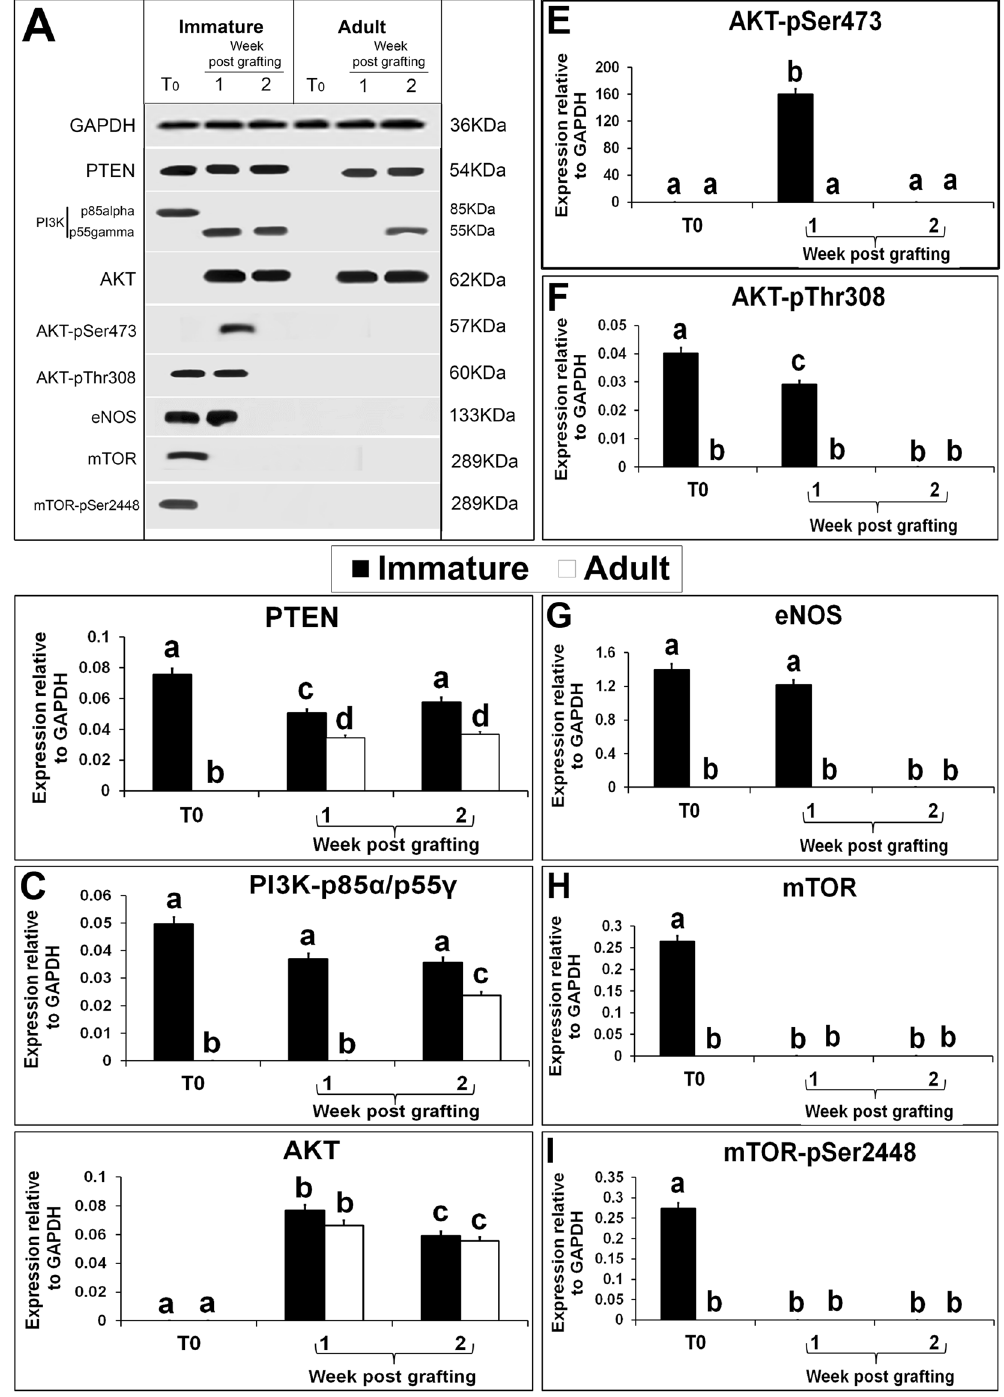
Figure 6. Western blot analysis of xenografted immature and adult testes at 1-and 2-wk-post grafting for expression of PI3K/AKT/mTOR pathway proteins. Protein expression in 6-day-old and 10-wk- old donor testes before grafting (T0) are presented as starting material. Representative blot ( A ) and densitometry analysis of ( B ) PTEN, ( C ) PI3Kp85alpha/gamma-pY467/199, ( D ) AKT, ( E ) AKT-pSer473, ( F ) AKT-pTyr308, ( G ) eNOS, ( H ) mTOR and (I) mTOR-pSer2448 protein. Y-axis represents intensity of bands relative to GAPDH. Data are presented as mean ± SEM. Bars with different letters are significantly different at P <